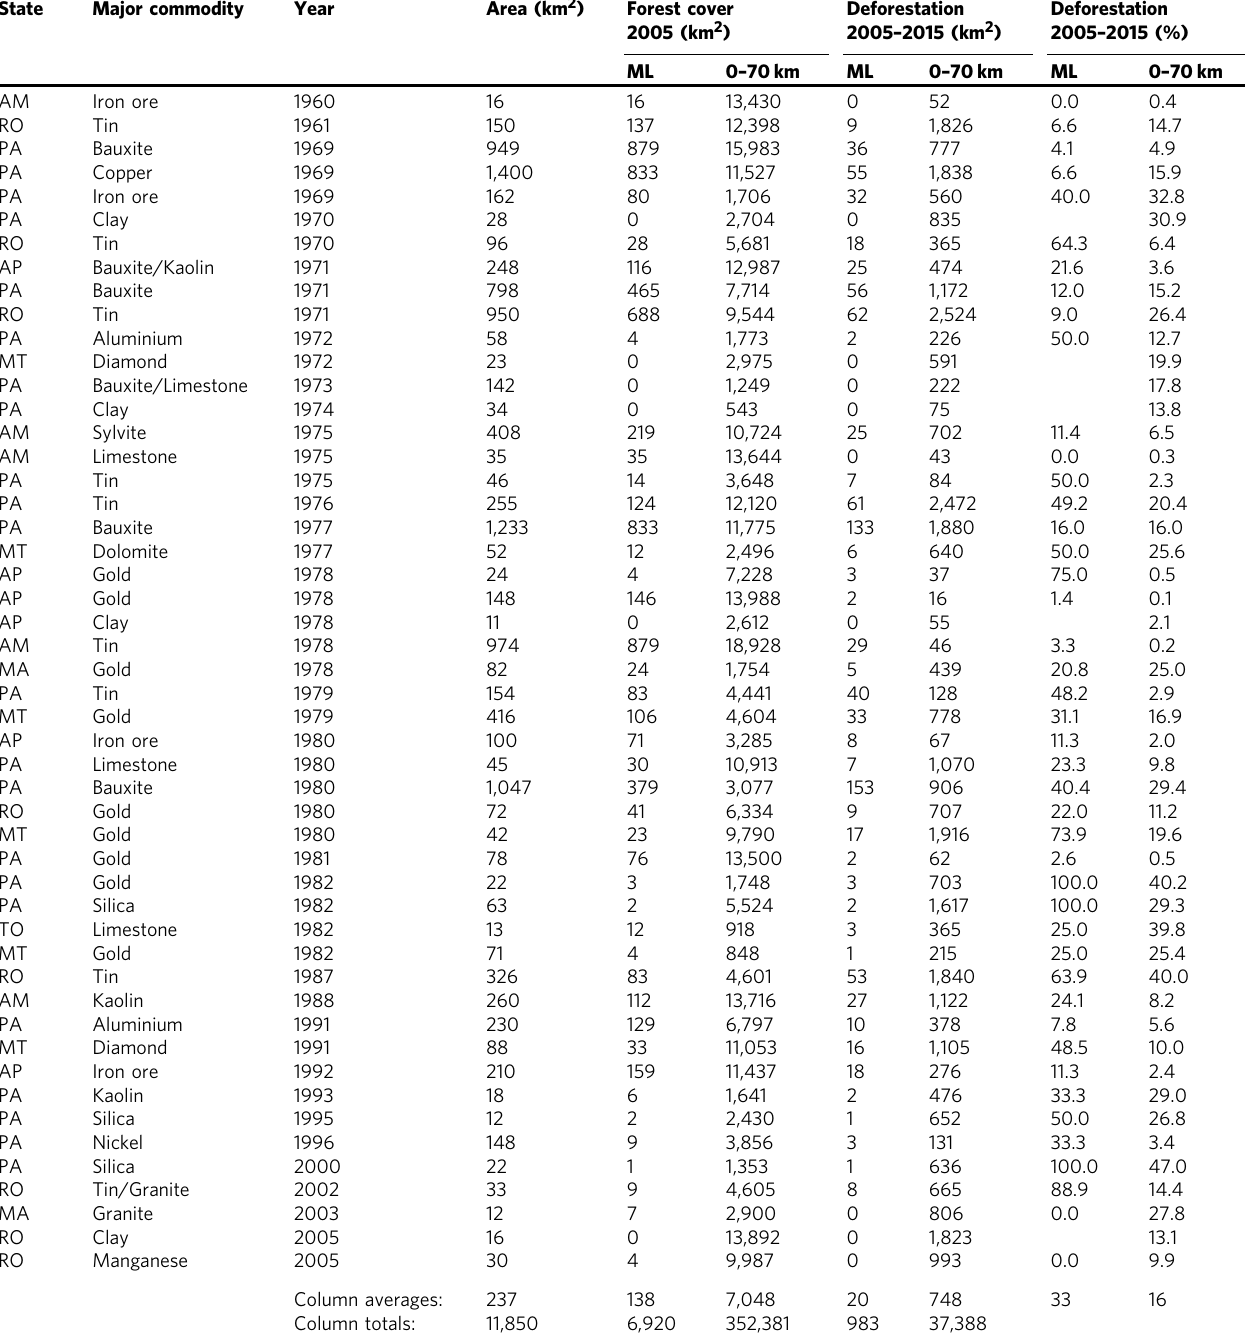
Table 1 Forest cover and deforestation 6 within mining leases and their surrounding 0 – 70 km